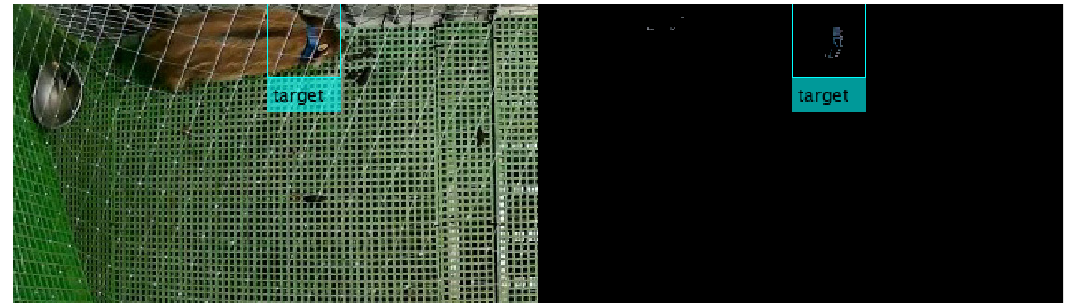
Figure 2. Random frame of fixed camera recording scene. Color threshold. ( Left ) Real frame corresponding to E1, where only two wild boar wore collars. ( Right ) Blue RGB filter applied to the same